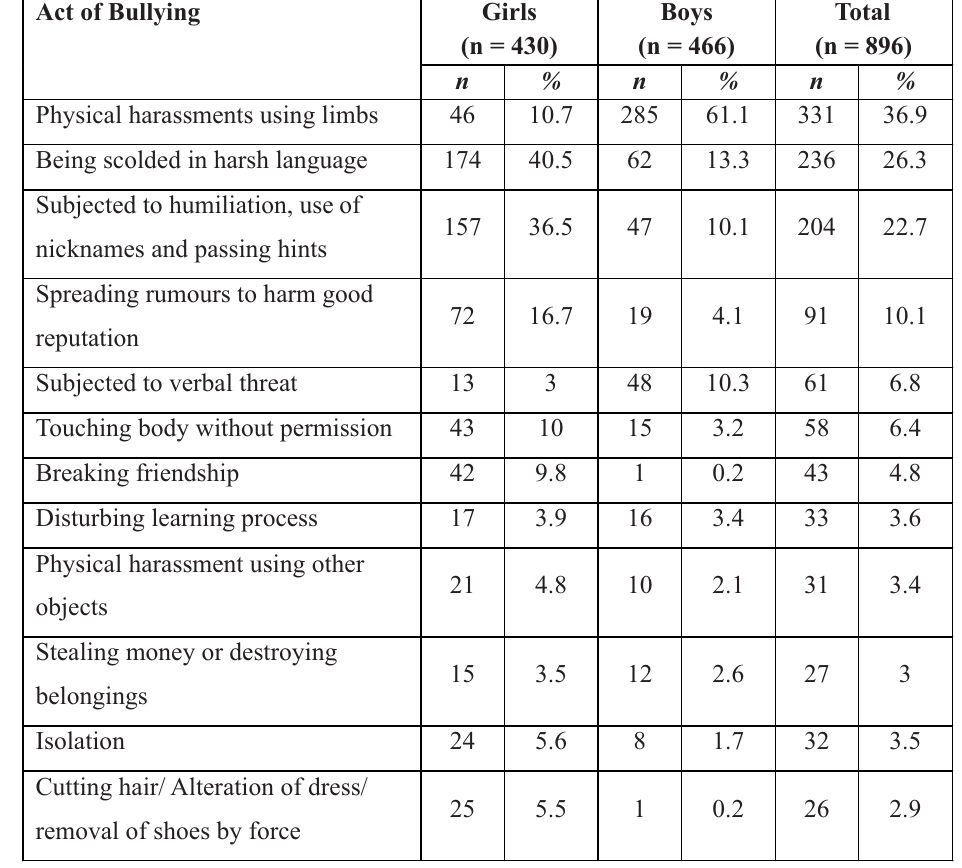
Table 1: Commonly reported acts of bullying according to sex Act of